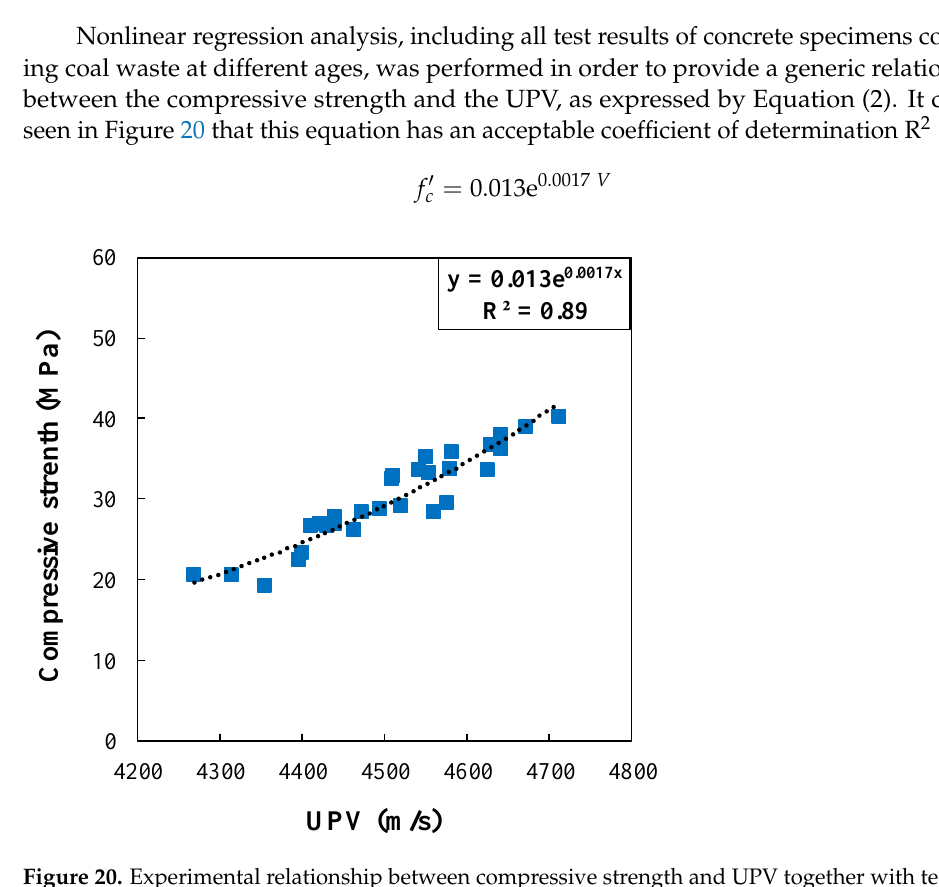
Figure 21. Comparison of the proposed model with experimental values of other researchers in literature and the present study.